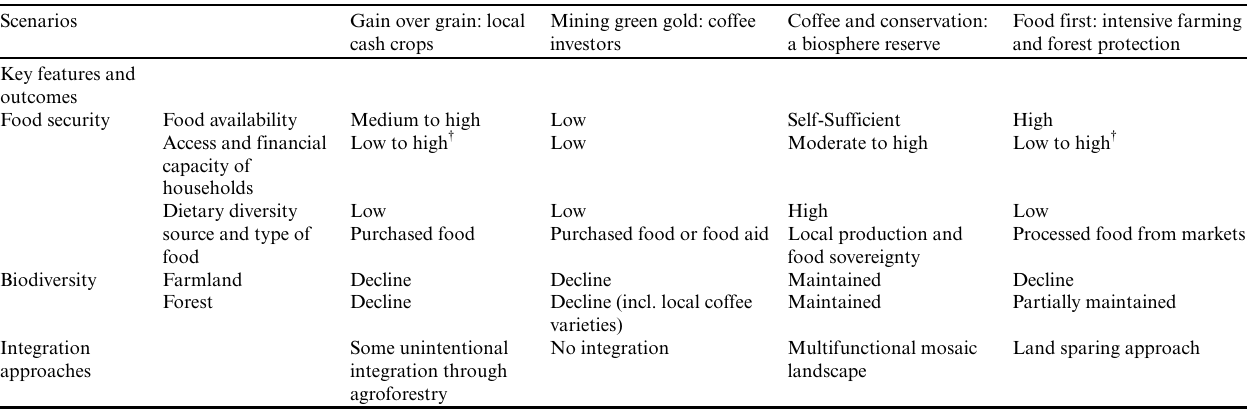
Table 2 . Outcomes of scenarios: Individual outcomes and integration of food security and biodiversity conservation in each of the scenarios. A dagger ( † ) indicates that those households that can afford to produce cash and food crops for markets obtain high financial incomes, whereas landless and poor people get poorer in terms of financial income under these scenarios. Scenarios Gain over grain: local Mining green gold: coffee Coffee and conservation: Food first: intensive farming cash crops investors a biosphere reserve and forest